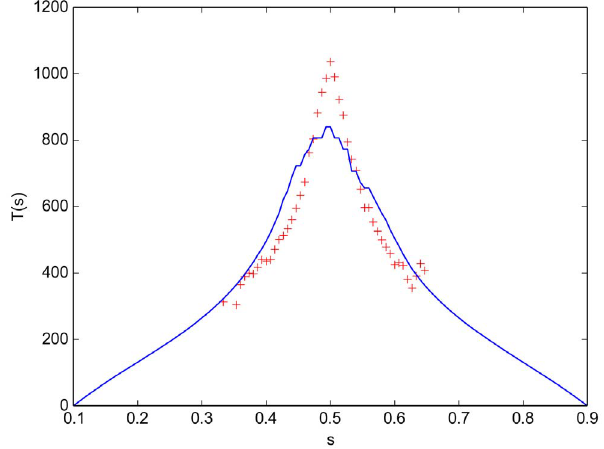
Figure 4. Decision time for a virtual swarm. Decision time T ( s ) as estimated from the simulation output [Eq. 58] (red markers) and computed from the FPE coefficients [Eq. (59)]. Simulation parameters are given in table